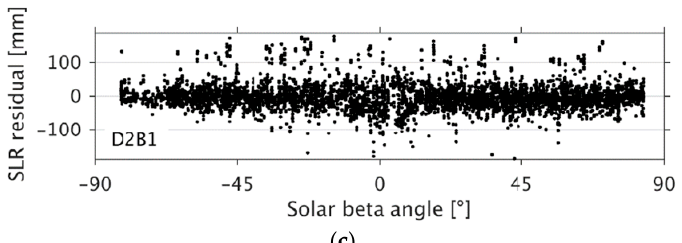
Figure 15. ( a ) SLR residuals as a function of the solar beta angle with respect to microwave-based orbits of GLONASS satellite SVN 747 over a three-year time span (January 2012 to December 2014): computed using the D0B1 parametrization of the ECOM model; ( b ) computed using the D4B1 parametrization of the ECOM model; ( c ) computed using D2B1 parametrization of the ECOM model.